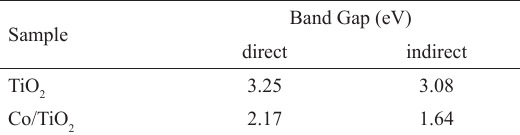
Table 2: The direct and indirect band gap values for pure and cobalt doped